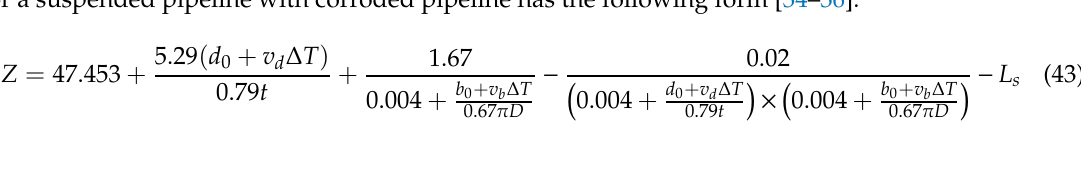
Table 4. Parameters of suspended pipeline with corrosion